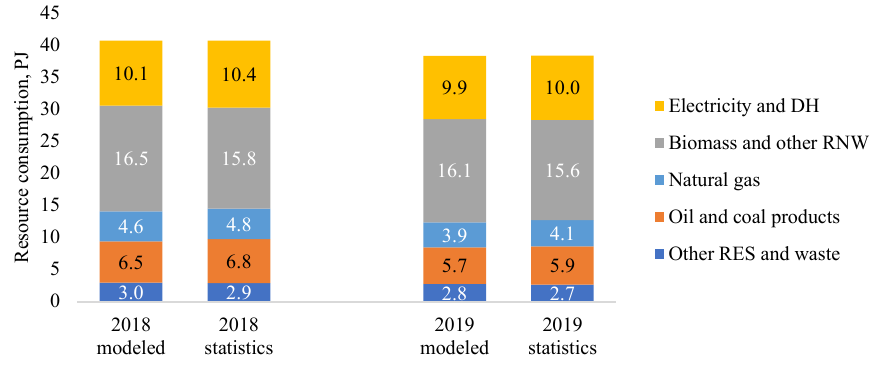
Fig. 4. Results of the model and statistical data [26] of resource consumption in industry sector for the years 2018 and 2019.